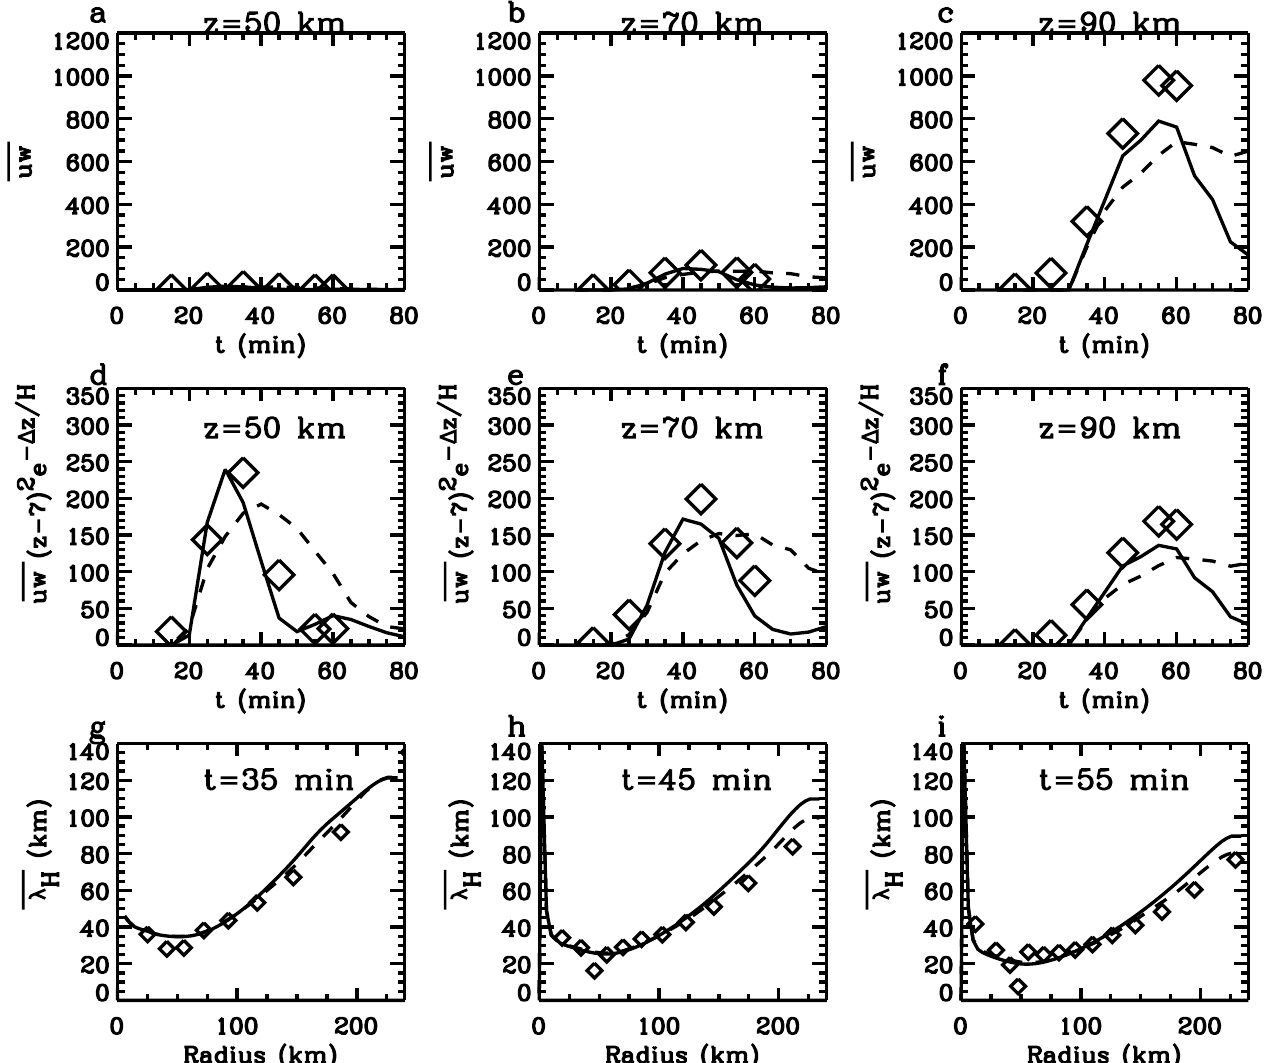
Fig. 10. Row 1: Average momentum fluxes from the smoothed ray traced solutions at z = 50, 70, and 90km in columns 1, 2, and 3, respectively. Solid (dash) lines show the ray trace results for the reflected (unreflected) GW spectrum normalized by Eq. (63) (Eq. 62). Diamonds shows the average momentum fluxes from the smoothed FL solutions shown in Fig. 5 and at t = 15 and 60min. (Note that the FL solutions have been multiplied by exp ((z − z trop )/ H ) to take into account the density decrease with altitude.) Row 2: Same as in (a) , but multiplied by (z − z 0 ) 2 exp ( − (z − z trop )/ H ) . Row 3: Average GW horizontal wavelengths as a function of radius at z = 90km and y = 0. Results are shown at t = 35, 45, and 55min in columns 1, 2, and 3, respectively. Solid (dash) lines show the ray trace values using the reflected (unreflected) GW spectrum. Diamonds shows the results from the FL